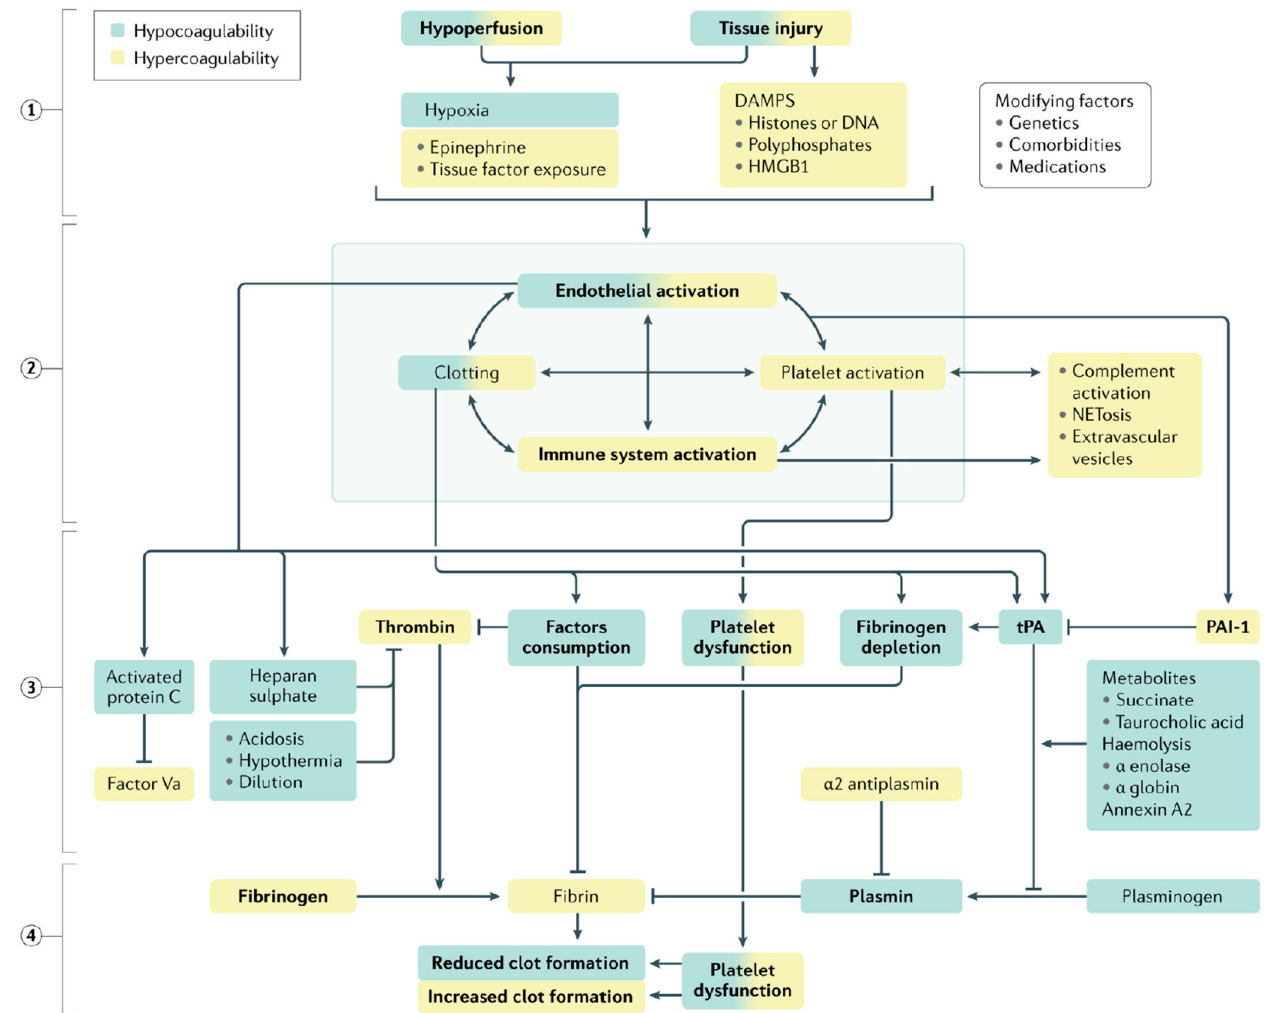
Figure 3. Qualitative changes in coagulation parameters in trauma-induced coagulopathy. Tissue injury and shock ① synergistically activate the endothelium, platelets and the immune system ② to generate an array of mediators that reduce fibrinogen, impair platelet function and compromise thrombin generation ③ , ultimately resulting in inadequate clot formation for hemostasis ④ . In- creased fibrinolysis via plasmin generation further compromises hemostatic capacity. These deficits are accentuated by ongoing blood loss, hemodilution, metabolic acidosis and hypothermia. A colour gradient indicates that the mechanism can result in both hypocoagulation (green) and hypercoagu- lation (yellow). DAMPs, damage-associated molecular pa tt erns; HMGB1, high mobility group pro- tein B1; PAI-1, plasminogen activator inhibitor-1; tPA, tissue plasminogen factor [62].